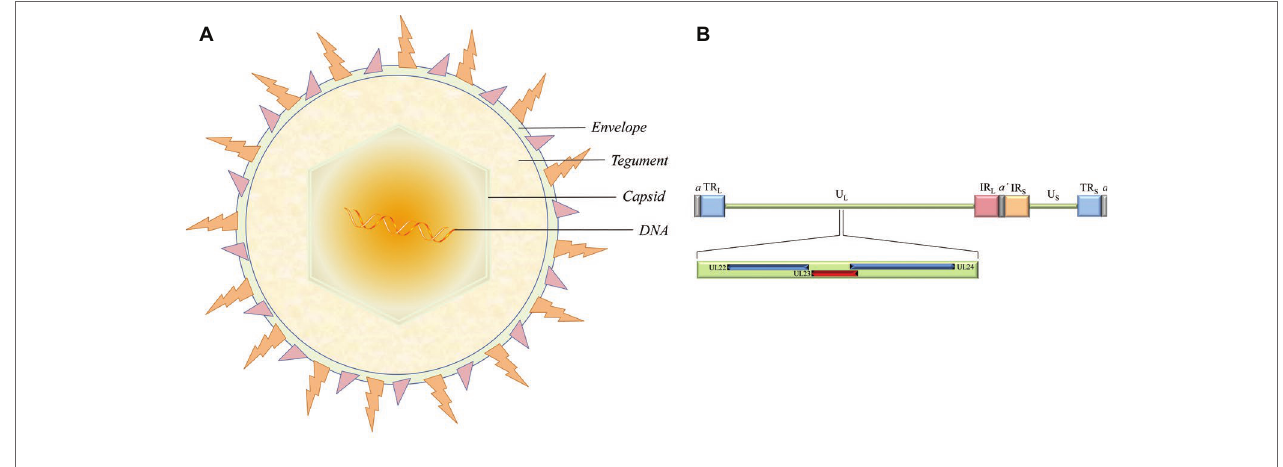
FIGURE 1 | The structure of virion and the location of the thymidine kinase gene (UL23) in the HSV-1 genome. (A) The virion is mainly composed of four morphologically distinct structures. (B) HSV-1 genomes contain U L and U S regions that are each flanked by terminal and internal inverted repeats (TR L /IR L and IR S /TR S ). The UL23 gene is located between UL22 and UL24 in the U L regions in the same orientation as the UL22 gene and the opposite orientation from the UL24